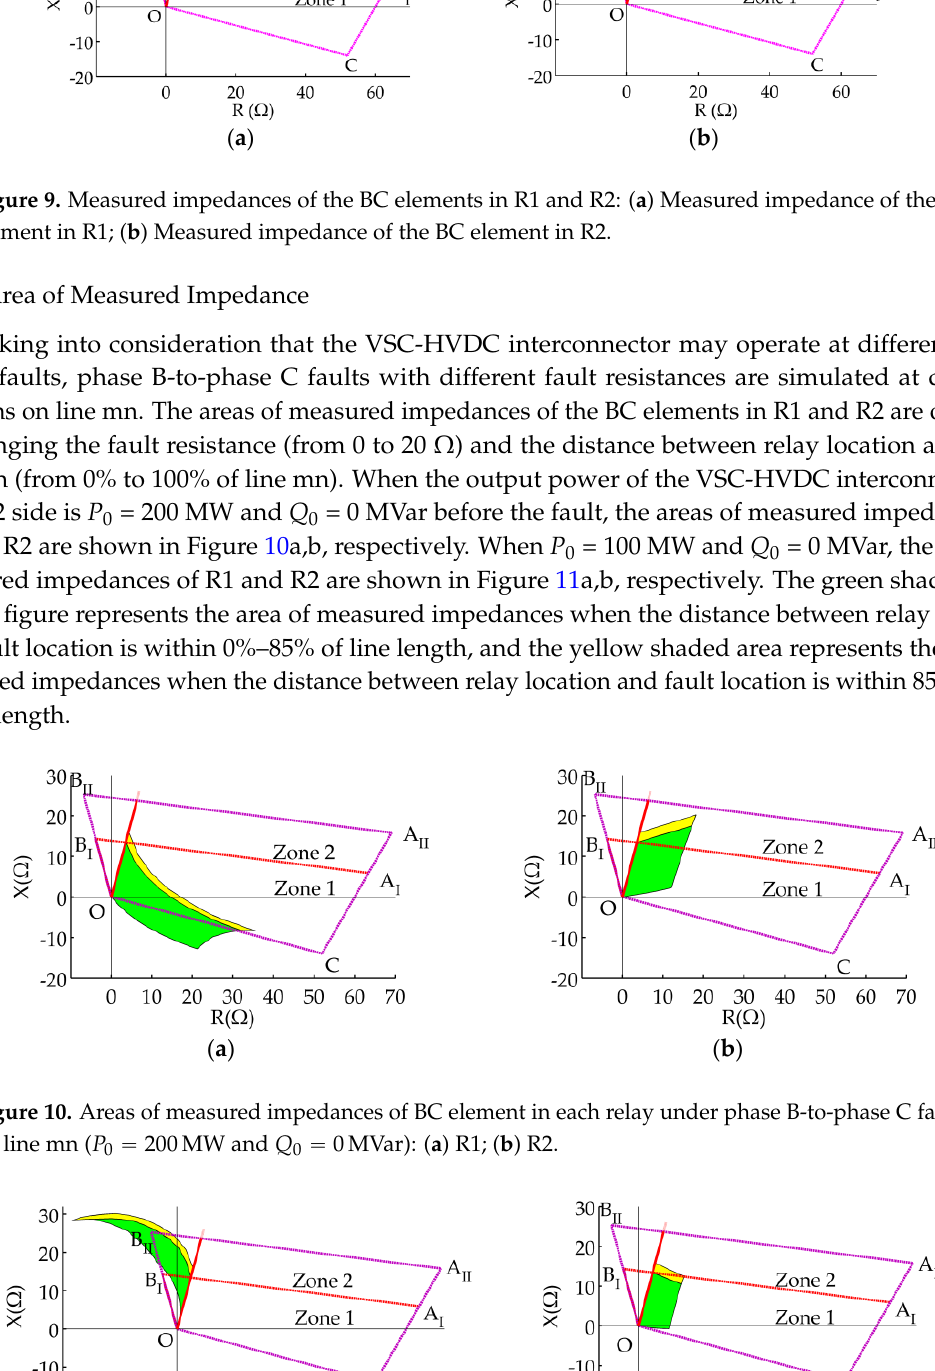
Figure 11. Areas of measured impedances of BC element in each relay under phase B-to-phase C faults on line mn ( 100 MW P and 0 MVar Q ): ( a ) R1; ( b ) R2.